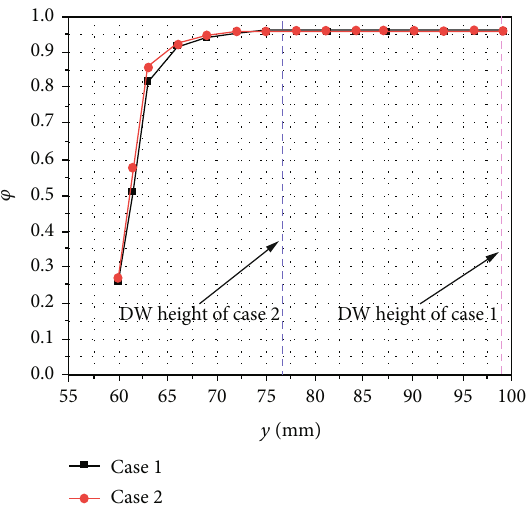
Figure 4: Mixing e ffi ciency comparison for two cases of cold fl